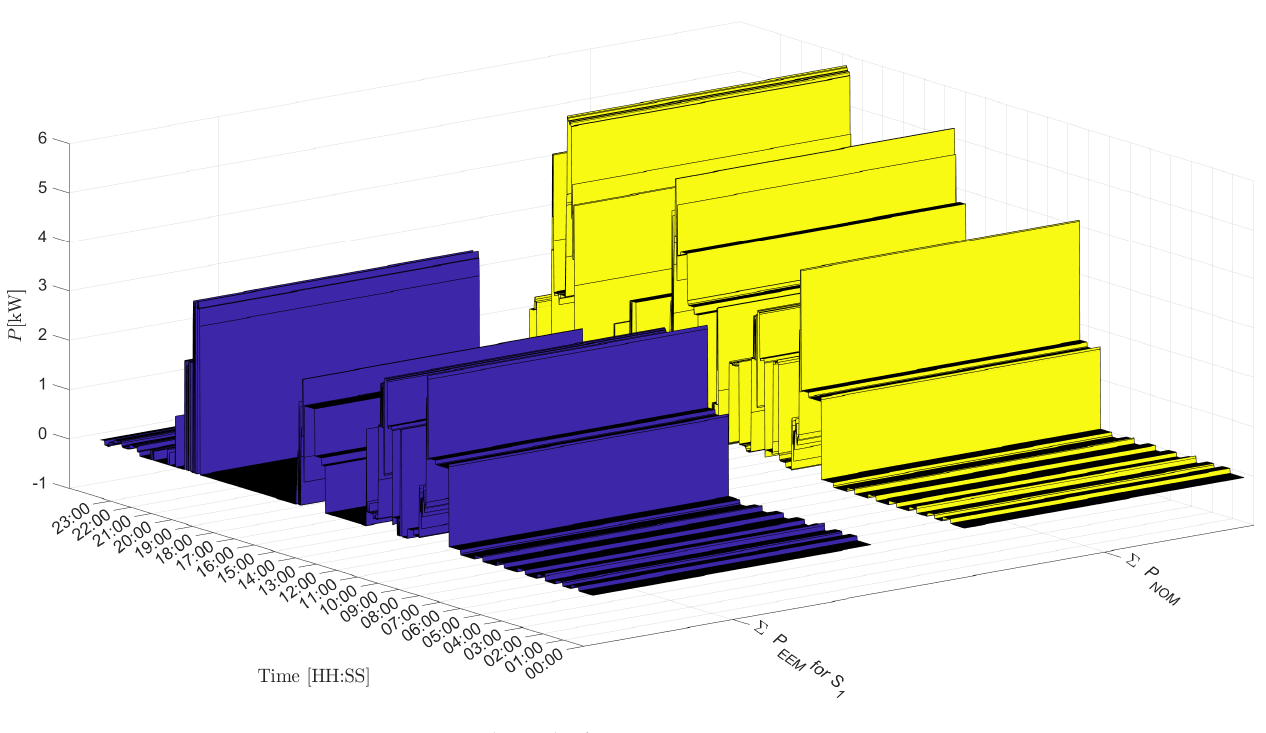
Figure 11. Research results for S 1 .